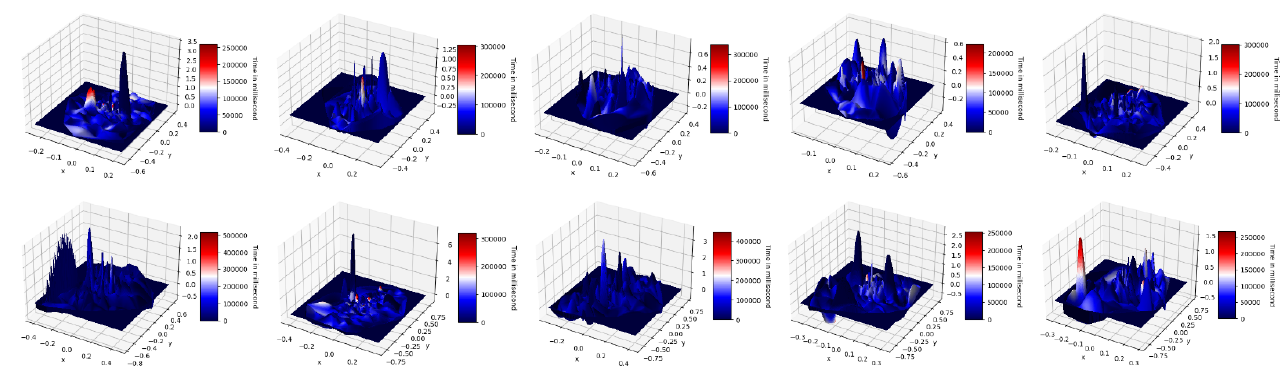
Figure 2. Smartwatch accelerometer data of 10 genuine signature signals from the same